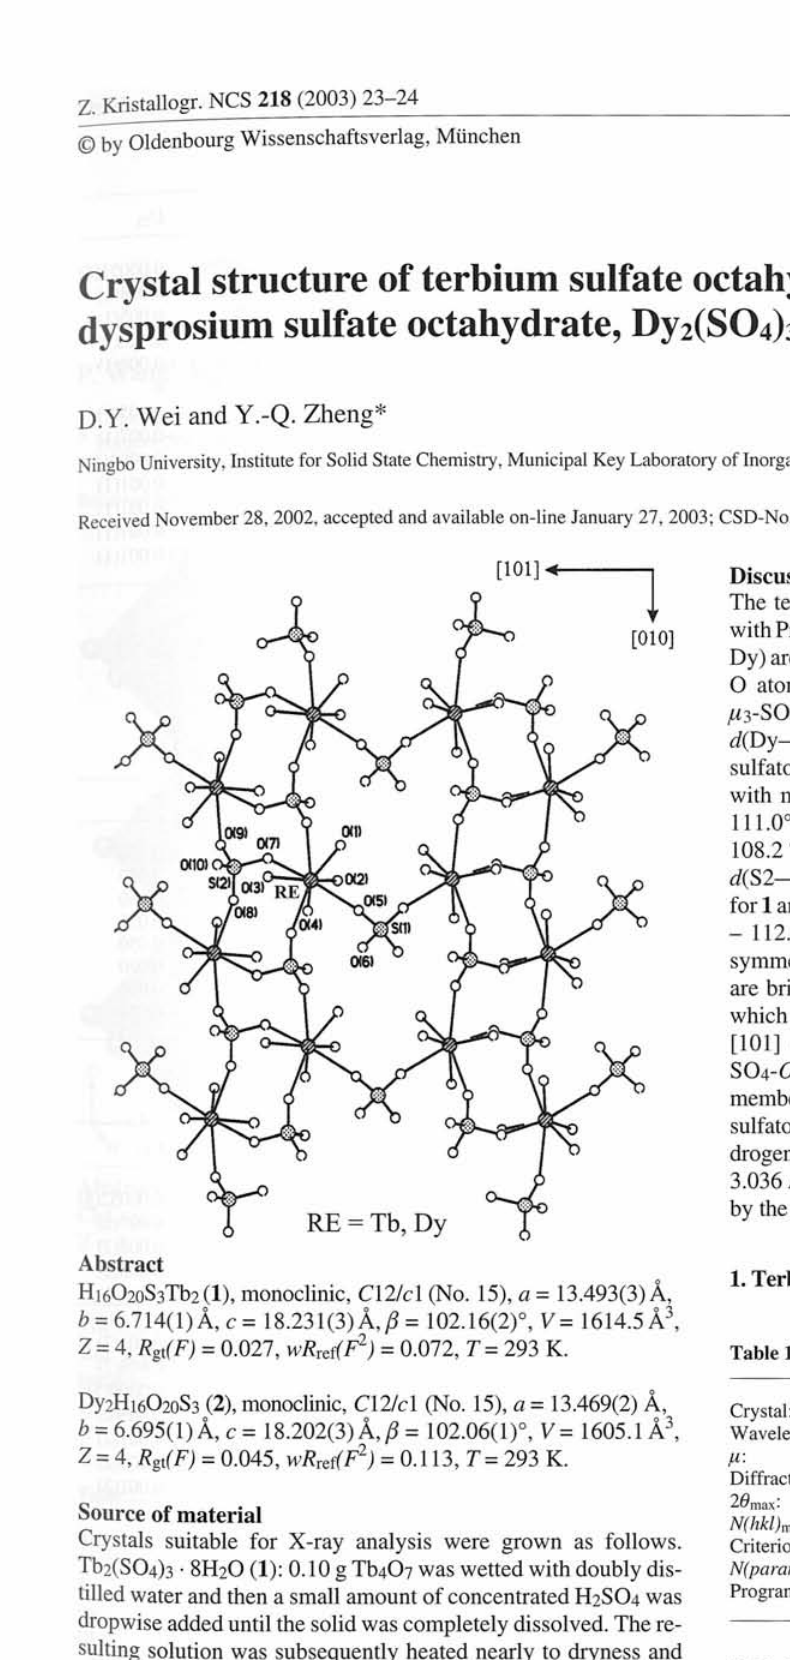
Table 2. Atomic coordinates and displacement parameters (in Â 1